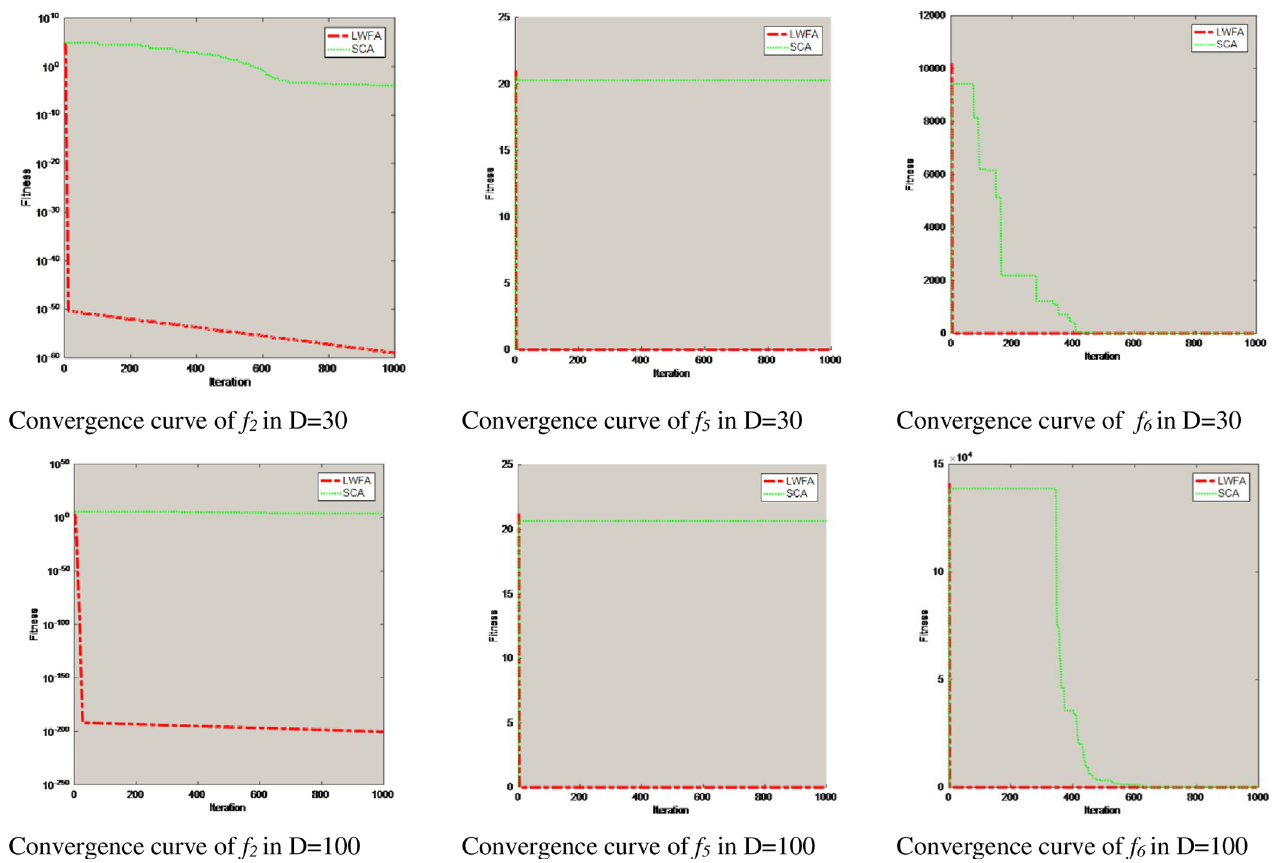
Fig 10. Contrast convergence curve of LWFA and SCA in D =